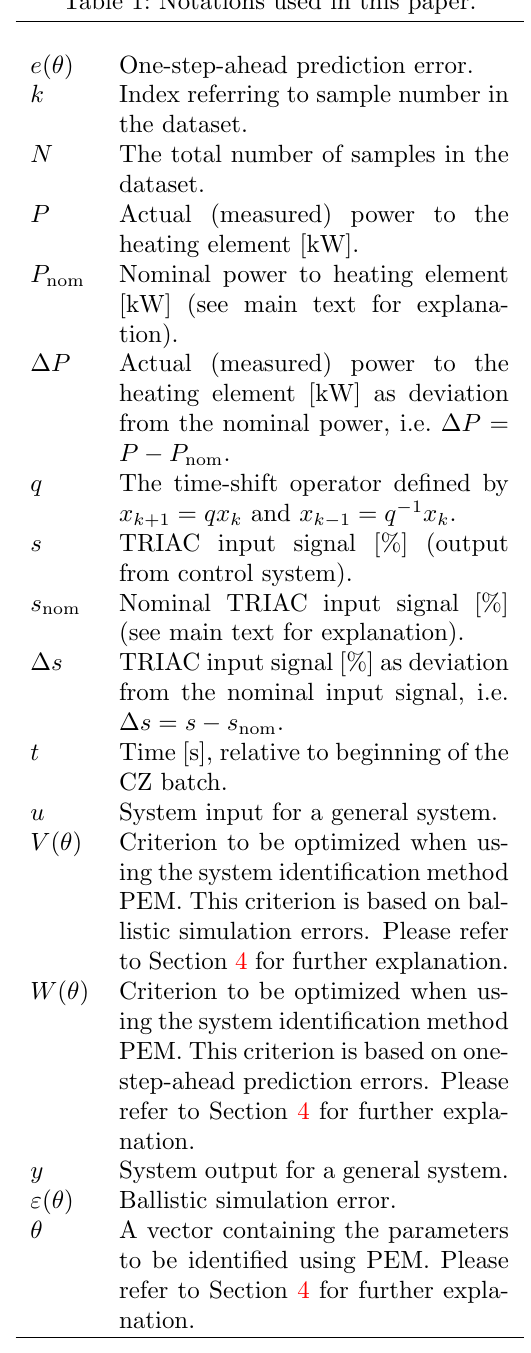
Table 1: Notations used in this